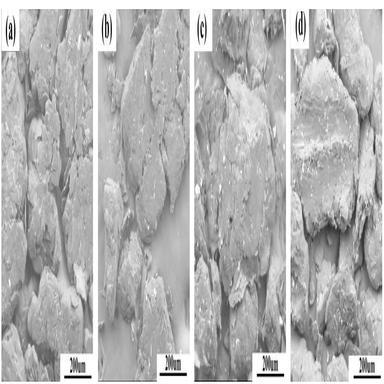
SEM images of CPCMs with different percentages of Si3N4: (a) 0 %, (b)1 %, (c) 3 %, and (d 5 %.